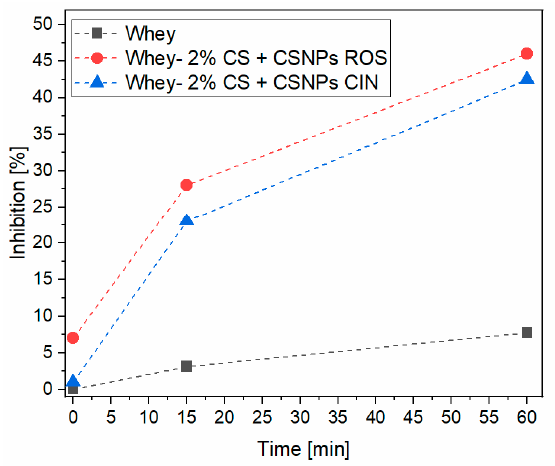
Figure 8. Antioxidative activity of functionalised whey-based laminates.